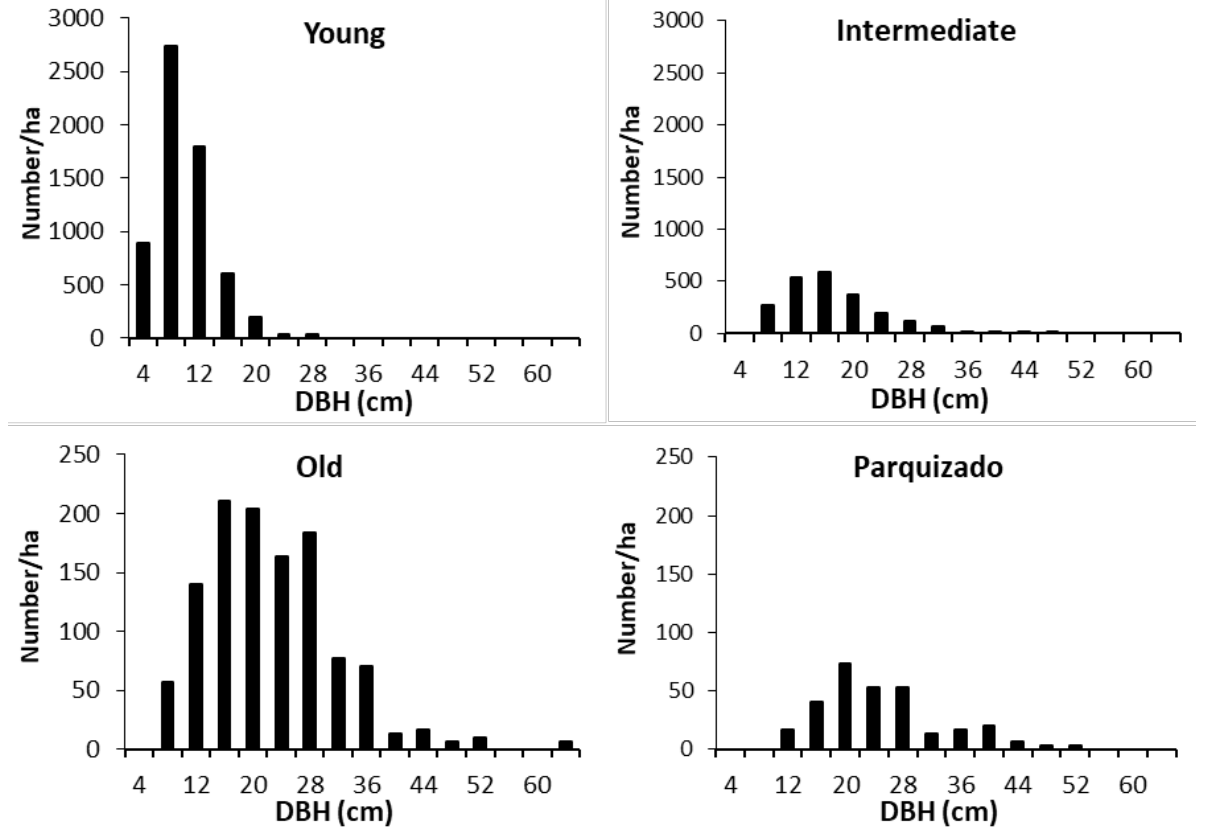
Figure 3. Diameter distributions of the different structures; the ordinates are differently scaled because otherwise, the charts with low number of stems/ha (old stands and parquizado) would not be readable.